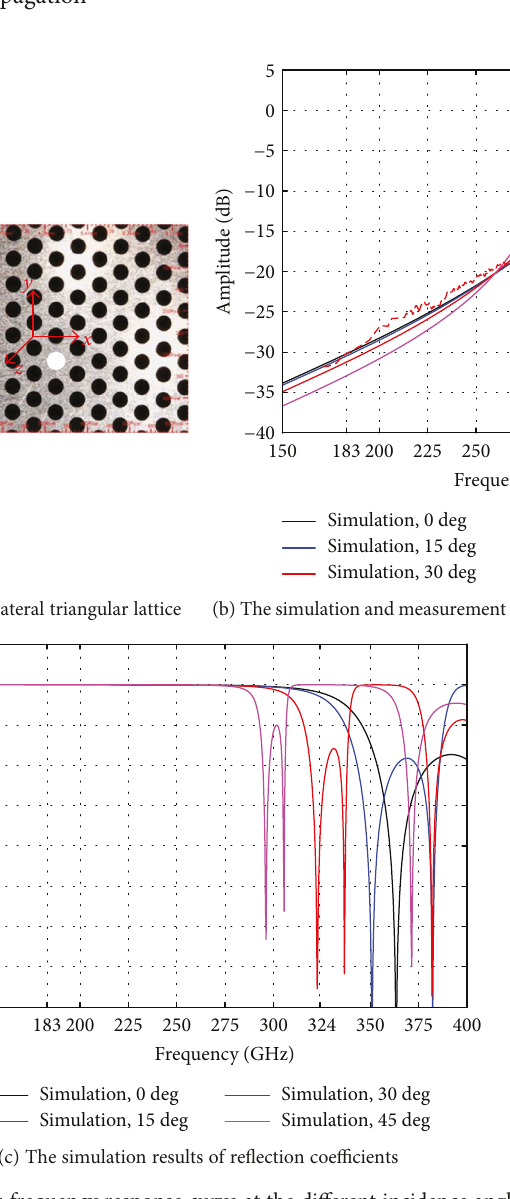
Figure 4: The structure of FSS and its frequency response curve at the di ff erent incidence angles of 0 ° , 15 ° , 30 ° , and 45 ° .